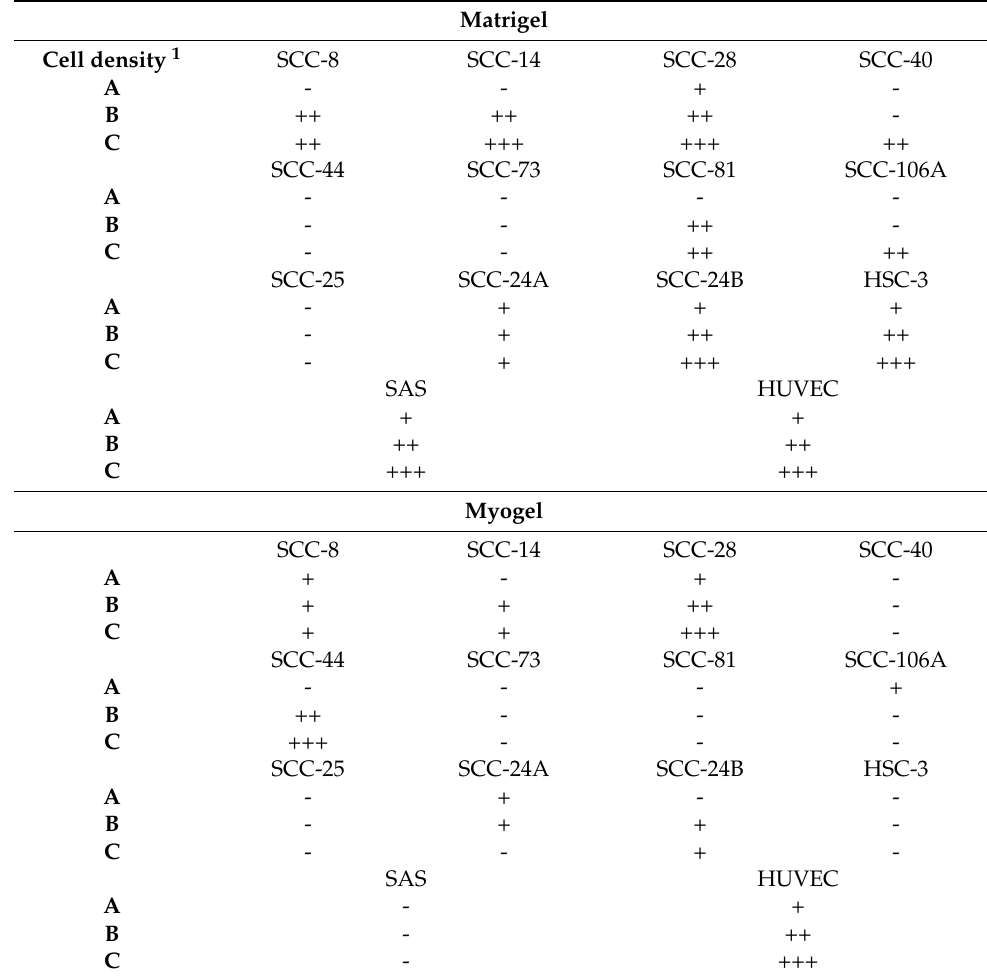
Table 1. Vascular mimicry-like network formation for head and neck squamous cell carcinoma and human endothelial cell lines in two different